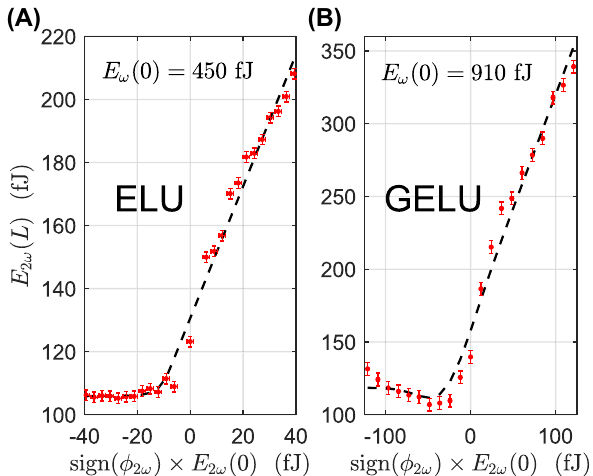
Figure 5: Pump–probe ultrafast timing measurements of the ReLU dynamics. The autocorrelation (yellow circles shifted vertically for clarity) of the input 𝜔 pulse is well-explained by a Gaussian profile (purple line) with FWHM of (56.4 ± 1.5) fs. The pump–probe signal obtained at a fixed pulse energy (blue circles) is fit (orange line)